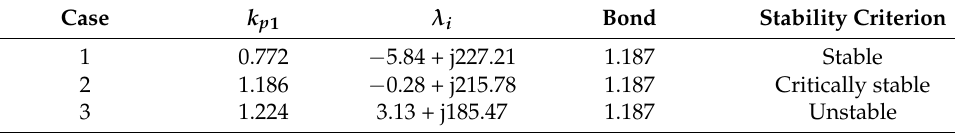
Table 1. The parameters of PMSG outer loop control.